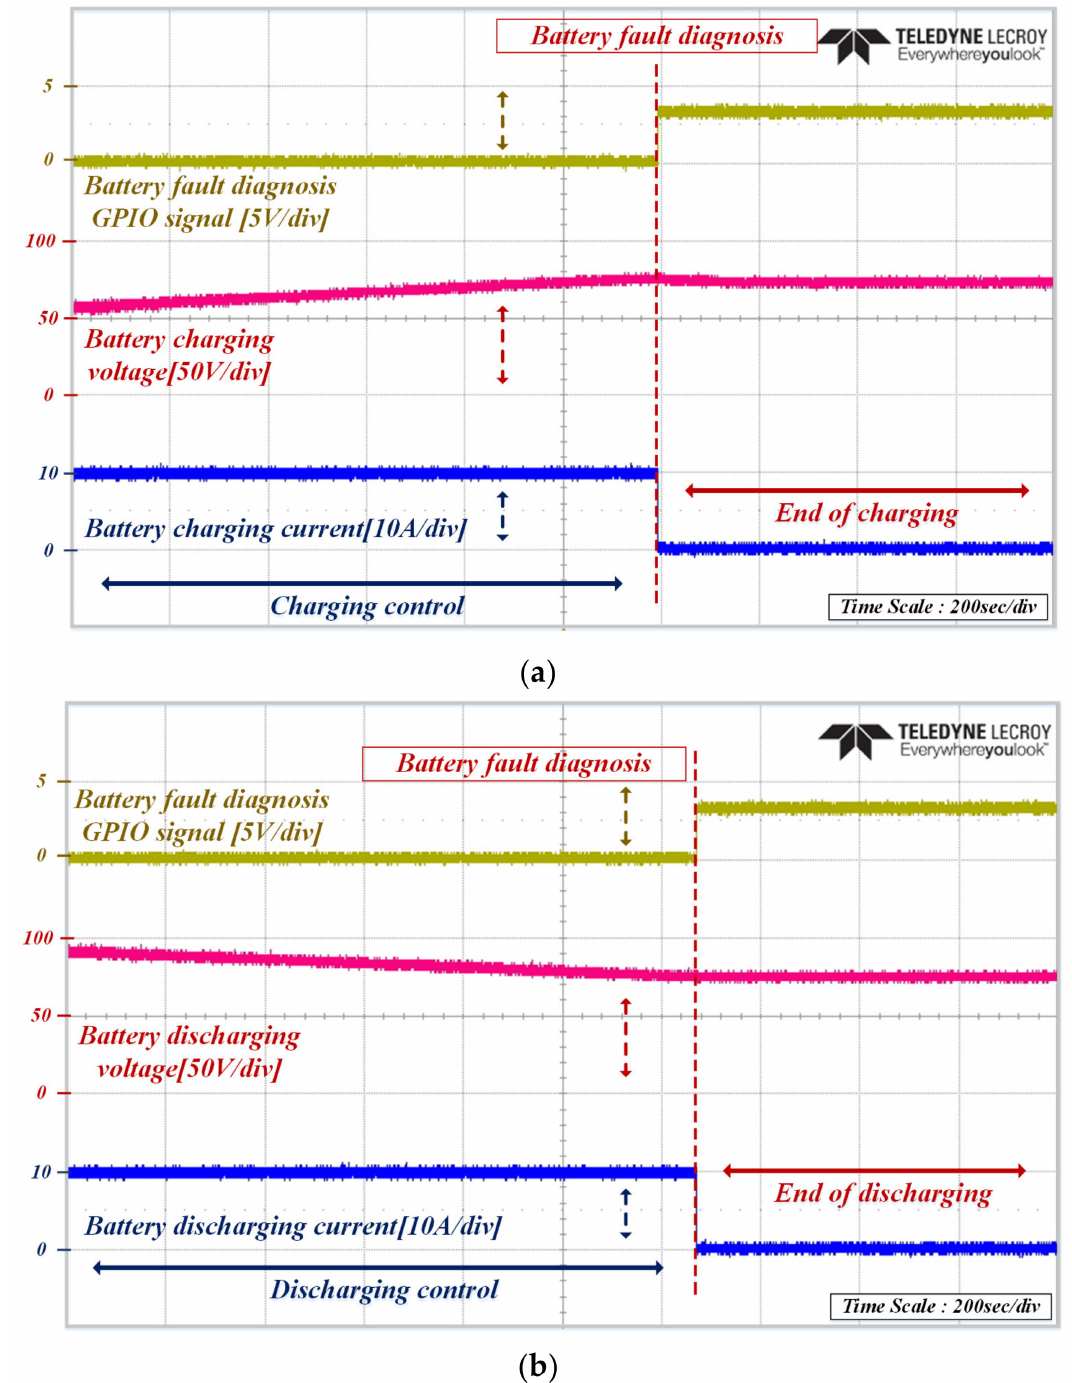
Figure 14. Waveforms for battery fault diagnosis: ( a ) charging voltage and charging current waveform; ( b ) discharging voltage and discharging current